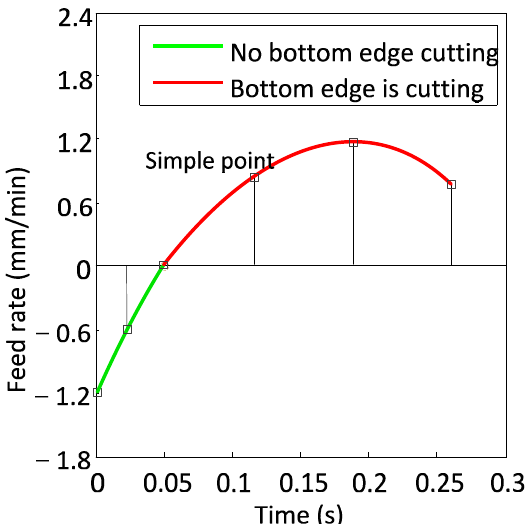
Figure 5. A number of instantaneous feed rates of the tool tip on a step are sampled and the maximum instantaneous bottom edge feed rate is determined.